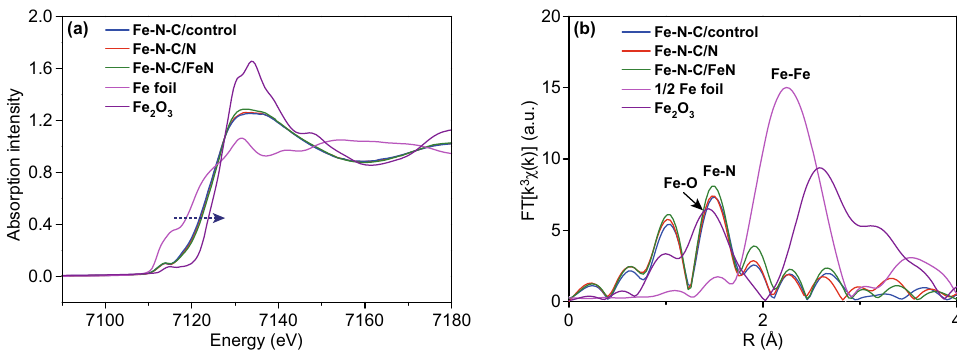
Fig. 4 a K-edge XANES spectra and b Fourier-transform EXAFS spectra of Fe–N–C, Fe–N–C/control, Fe–N–C/N, Fe–N–C/FeN, Fe foil, and